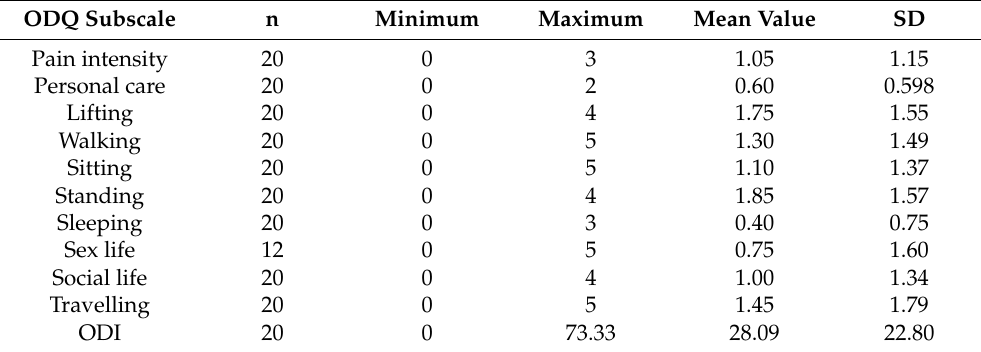
Table 4. Mean values of the Oswestry Low Back Pain Disability Questionnaire (ODQ) and Disability Score